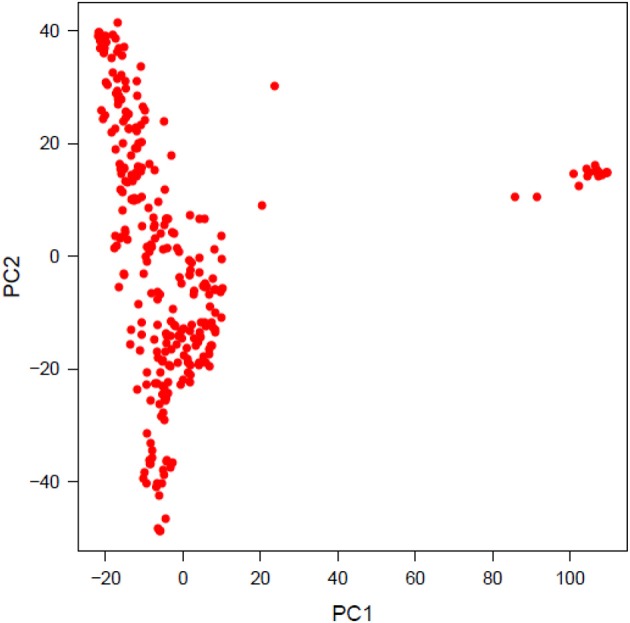
Principal component analysis of 288 diverse genotypes used for GWAS.